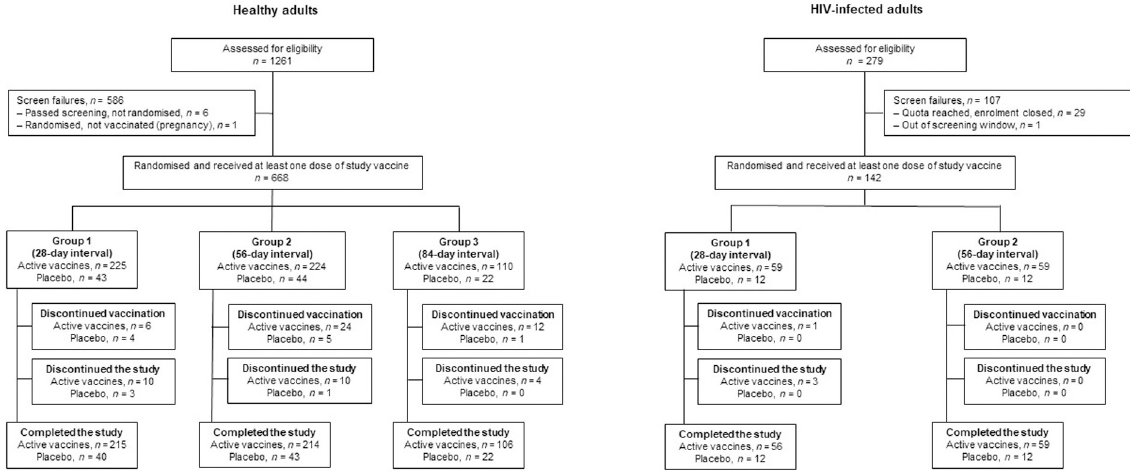
Fig 1. Study disposition of healthy adults and HIV-infected adults. n = number of participants.